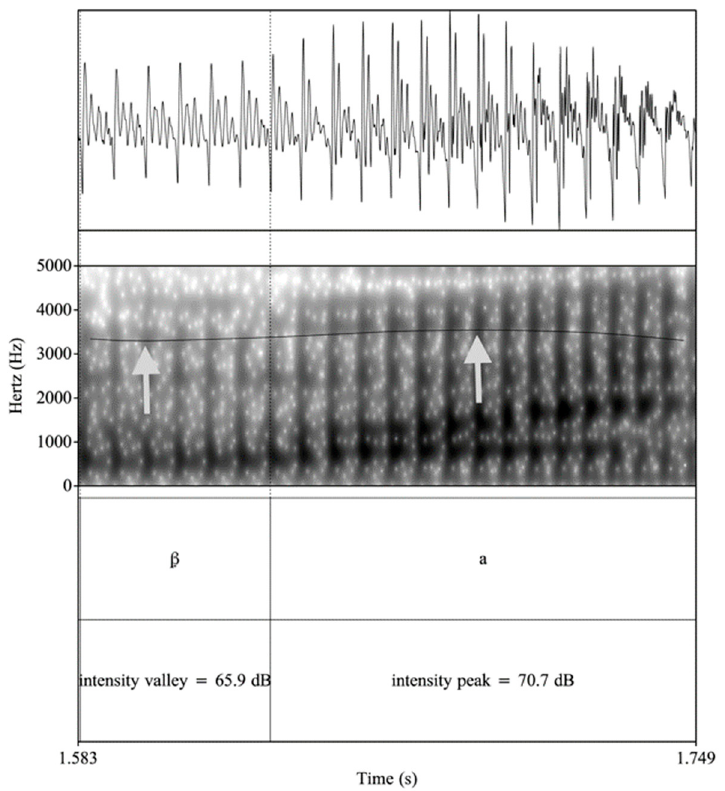
Figure 3. Spanish production of intervocalic /b/ in cabaña ‘cabin’.